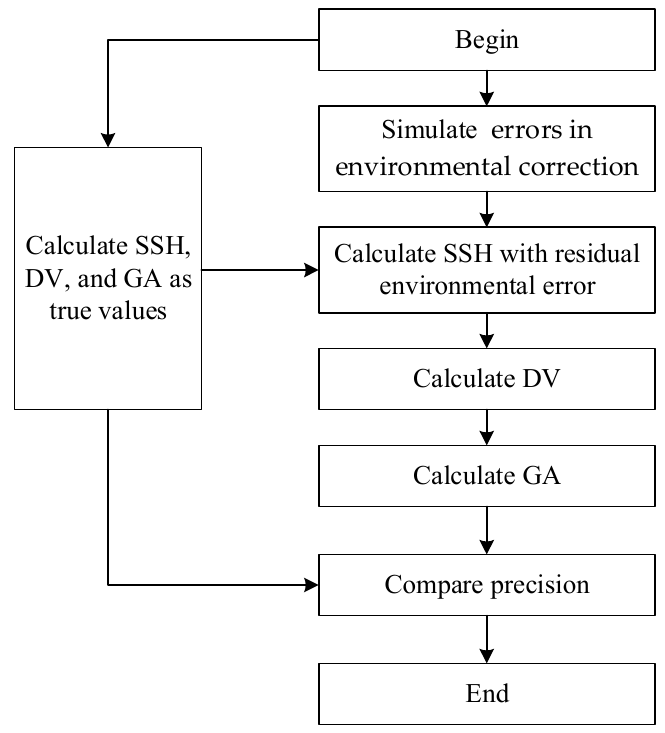
Figure 3. Data processing flow chart.